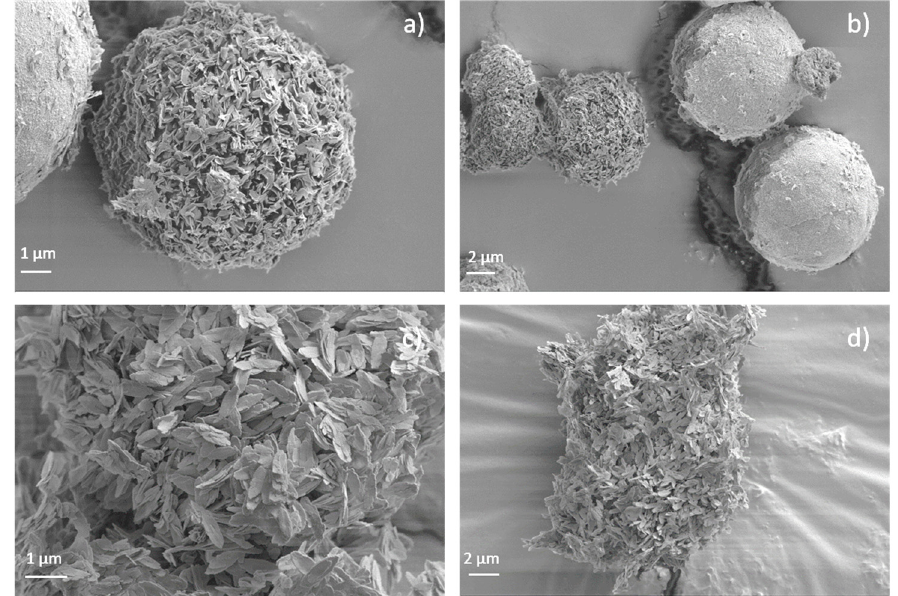
Figure 10. FESEM micrographs of the samples calcined at 550 °C: images ( a , b ) correspond to CIM- 80_10-C-550 °C and images ( c , d ) correspond to AlO(OH)-C-550 °C. 80_10-C-550 ◦ C and images ( c , d ) correspond to AlO(OH)-C-550 ◦